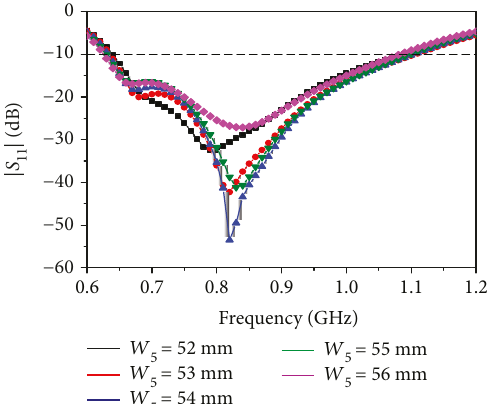
ff erent lengths of the horizontal stub 11 for di